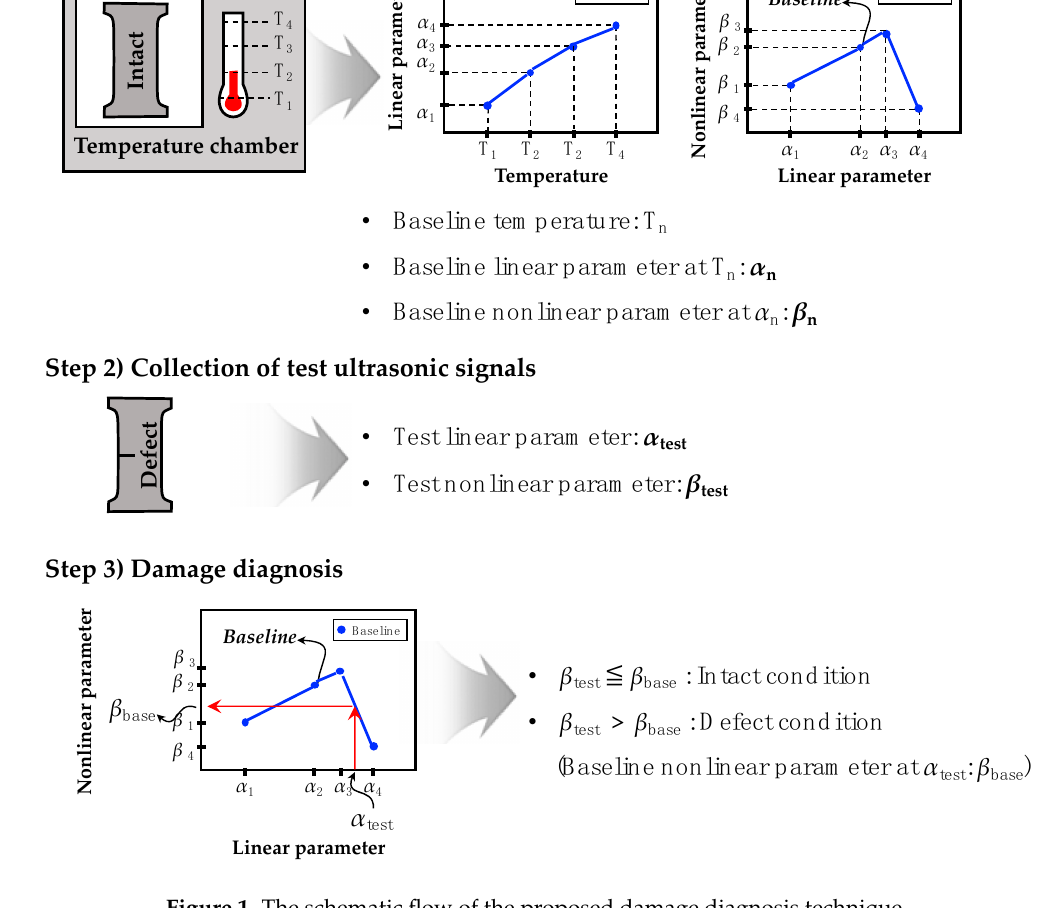
Figure 1. The schematic flow of the proposed damage diagnosis technique.